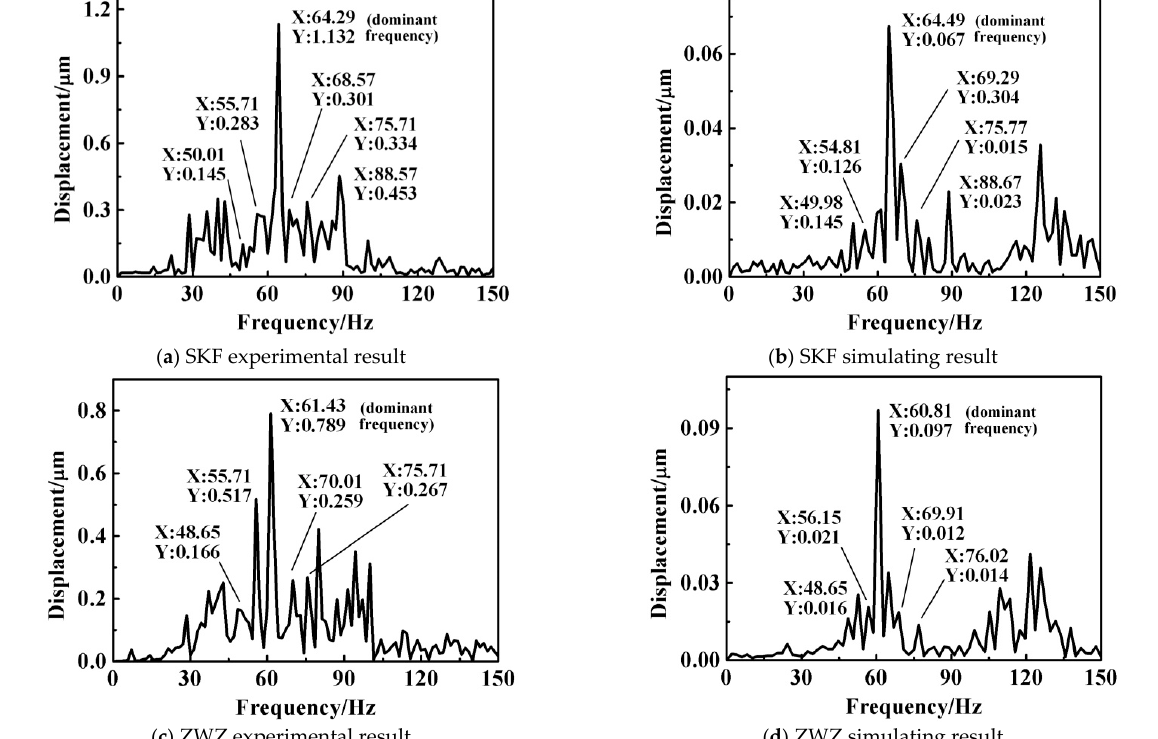
Figure 22. The displacement vibration spectrum of SRBs with type 22215 from different manufacturers under adaptive self-aligning operating conditions.